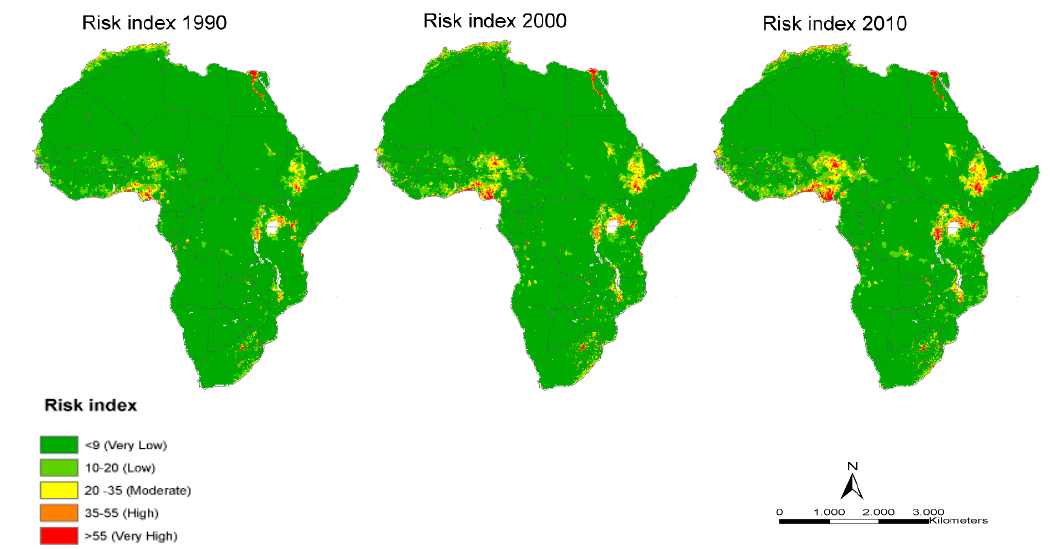
Figure 5. Groundwater pollution risk for 1990, 2000, and 2010.